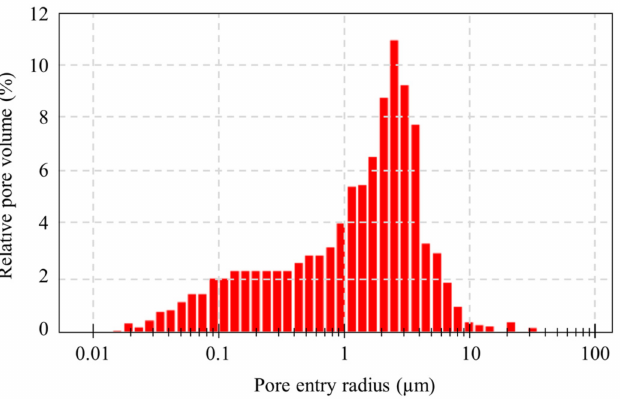
Figure 1. Pore size distribution of Lecce stone determined by mercury intrusion